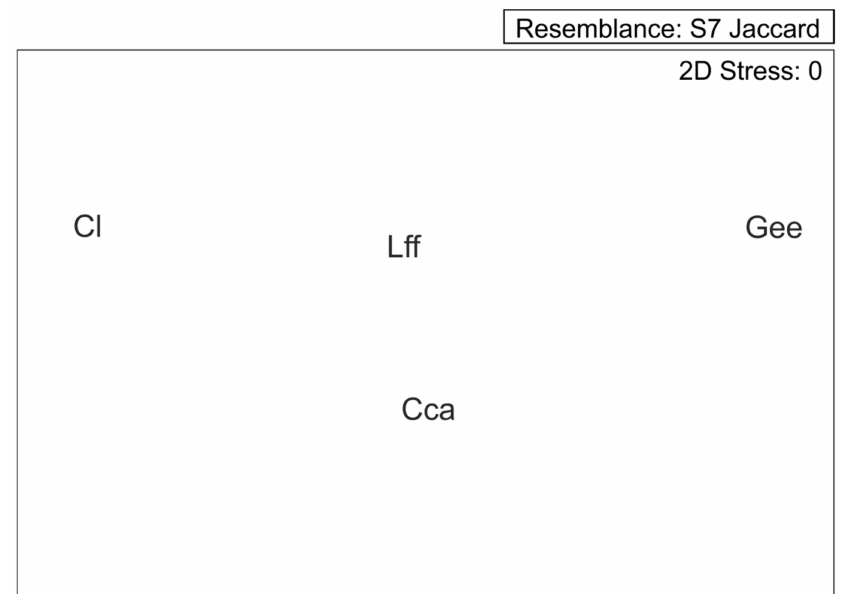
Figure 3. Jaccard similarity between the studied tiger beetle species based on their habitat preferences: Gee: Grammognatha euphratica euphratica , Cl: Calomera lunulata , Cca: Cicindela campestris atlantis , L ff : Lophyra flexuosa flexuosa .